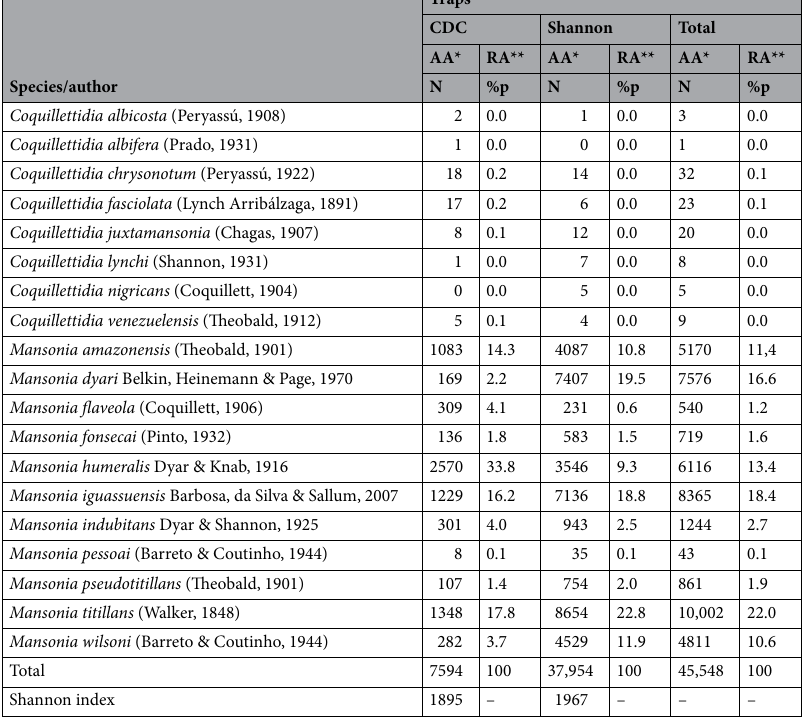
Table 5. Abundance and Shannon diversity index of tribe Mansoniini specimens captured in the CDC and Shannon traps installed in areas near the Jirau hydroelectric plant in Rondônia state, Brazil, in 2018 and 2019. * Absolute abundance. * * Relative abundance.